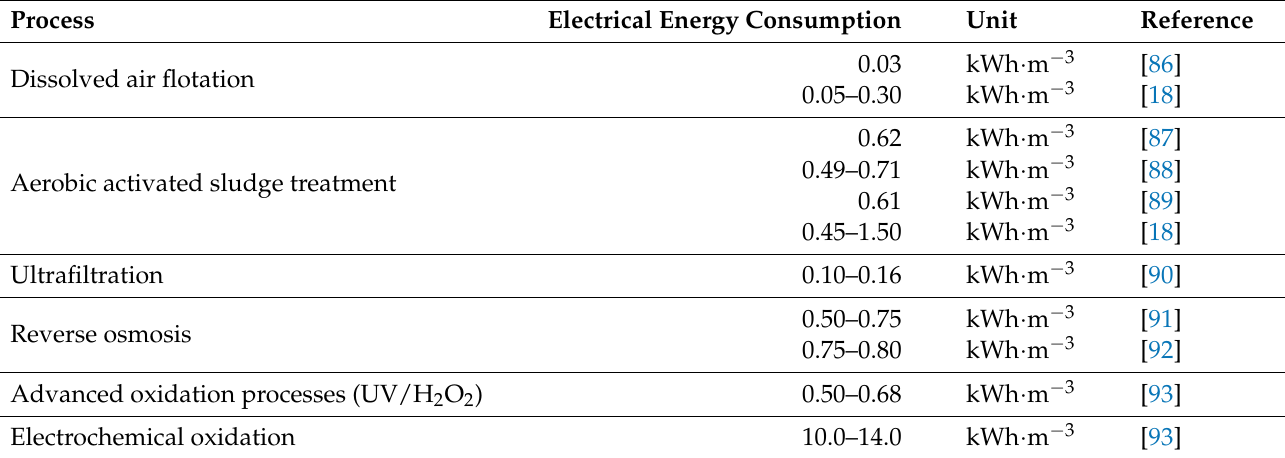
Figure 13. Energy outcome of the models. Table 8. Energy consumption of the treatment